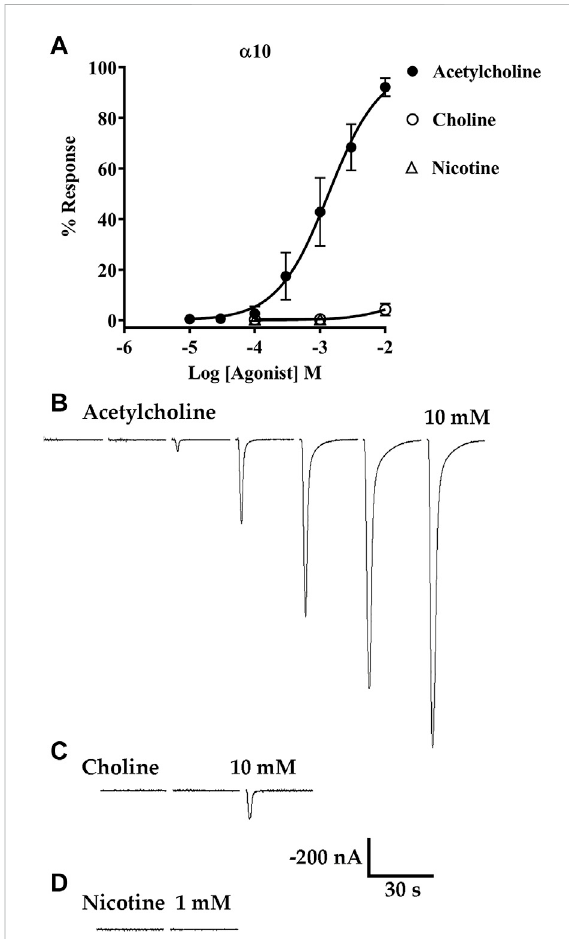
FIGURE 9 Acetylcholine (ACh) and choline, but not nicotine, evoke currents from oocytes expressing α 10 nAChRs. X. laevis oocytes were injected with cRNA encoding human α 10 subunits and incubated for 3 – 4 days in frog saline containing STR (20 μ M) then assessed by voltage-clamp electrophysiology. (A) Concentration-response curve for acetylcholine, choline, and nicotine. The EC 50 for activation of α 10 nAChRs by ACh was 1.35 (1.15 – 1.58) mM and the Hill Slope was 1.1 (0.9 – 1.3) (n = 5). Choline was a partial agonist but evoked detectable currents only at 10 mM; the maximal response was 4 ± 2% (n = 5) of the calculated maximal response to ACh. Nicotine failed to induce detectable currents at concentrations up to 1 mM (n = 5). (B) Current traces evoked by 10 μ M, 30 μ M, 100 μ M, 300 μ M, 1 mM, 3 mM, and 10 mM ACh. (C) Current traces evoked by 100 μ M, 1 mM, and 10 mM choline. (D) Current traces from an oocyte stimulated with 100 μ M and 1 mM nicotine. All current traces in (B – D) were obtained from the same oocyte and are shown with the 35 s interpulse intervals reduced to 5 s for brevity. The current amplitude and time-scale bars apply to all traces in B-D. Values in parentheses indicate the 95% CI and the “ ± ” indicates SD; “ n ” indicates the number of oocytes obtained from one